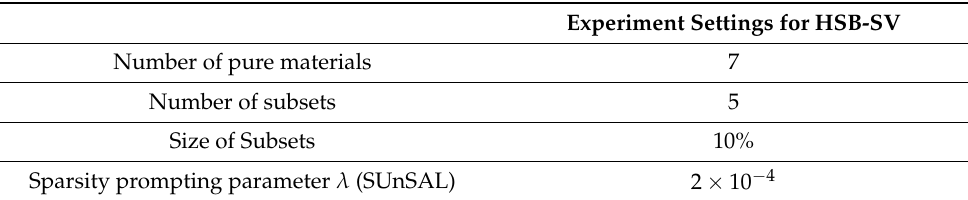
Table 7. Considered parameters for HSB-SV for the real